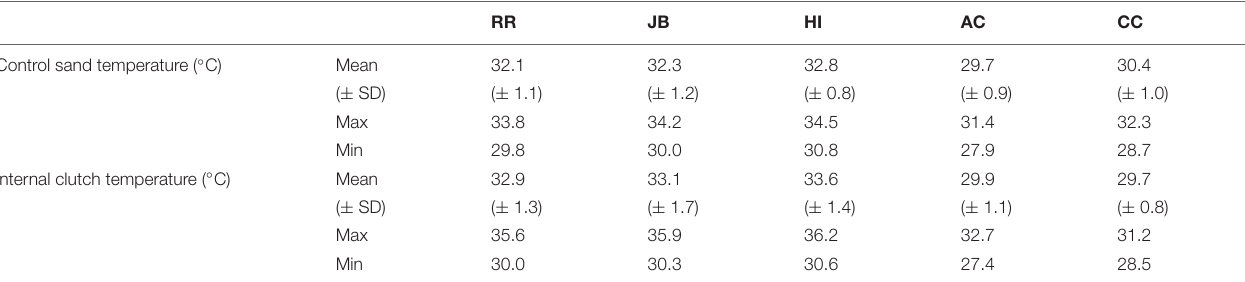
TABLE 3 | Mean ( ± SD), minimum and maximum daily clutch temperatures and adjacent (control) sand temperature at 45 cm deep for the five study beaches during the 2020 nesting season.